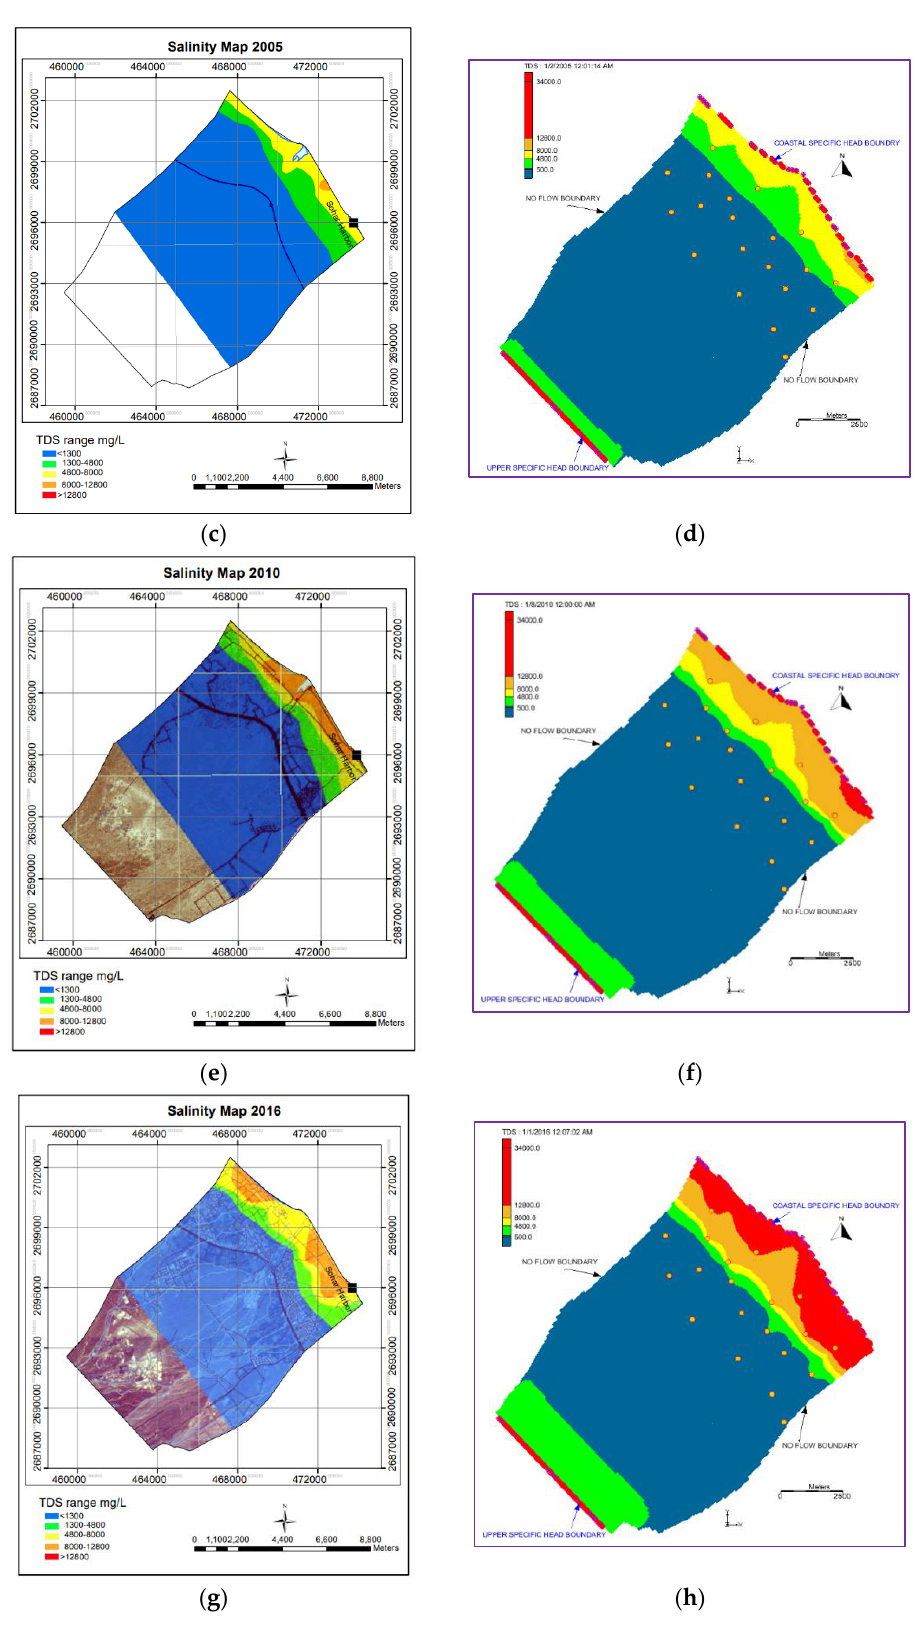
Figure 5. Salinity contour maps. ( a ) Year 2000 observations, ( b ) year 2000 simulations, ( c ) year 2005 observations, ( d ) year 2005 simulations, ( e ) year 2010 observations, ( f ) year 2010 simulations, ( g ) year 2016 observations, and ( h ) year 2016